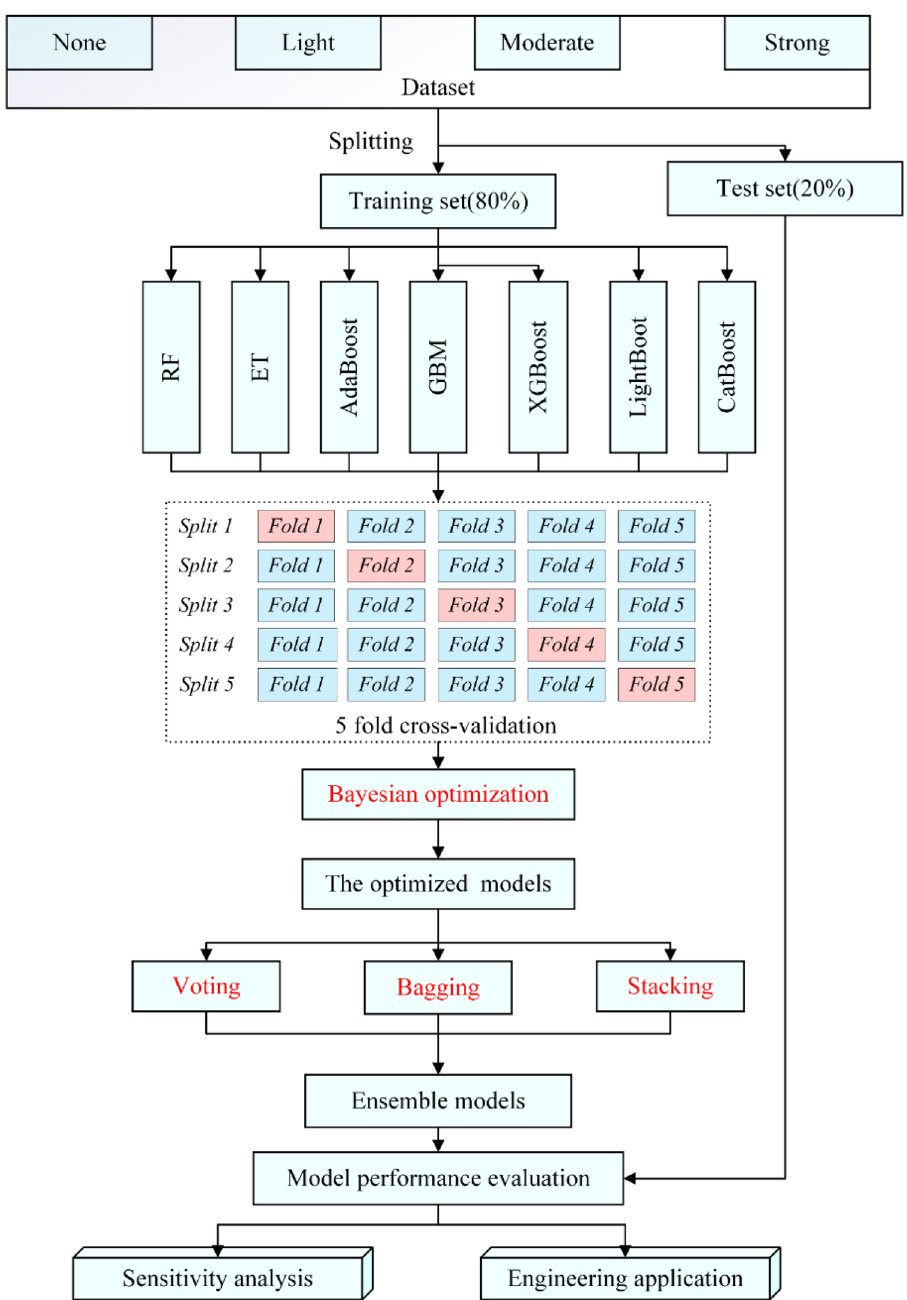
Figure 4. The flowchart of the modeling procedure in this